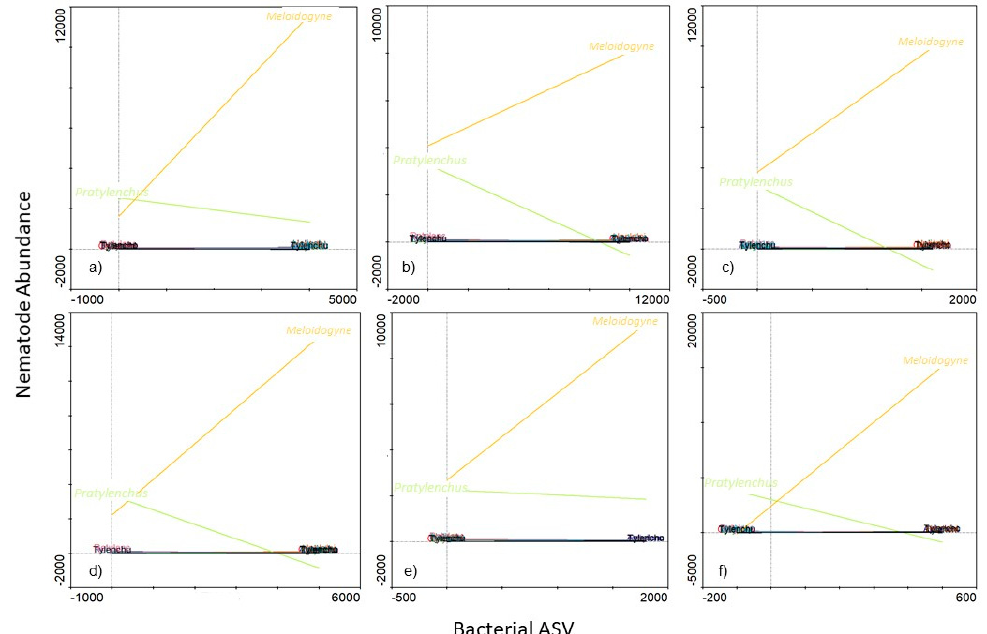
Figure 9. A functional response graph showing the correlation between the abundance (Bacterial ASV) of the genera Bacillus2 ( a ), Gemmata1 ( b ), Pirellula3 ( c ), Streptomyces2 ( d ), uncultured15 ( e ), uncultured30 ( f ) and the abundance of Meloidogyne (orange line) and Pratylenchus (green line) that were extracted from soybean roots sampled from the Highveld production area in the Mpumalanga province, South Africa.